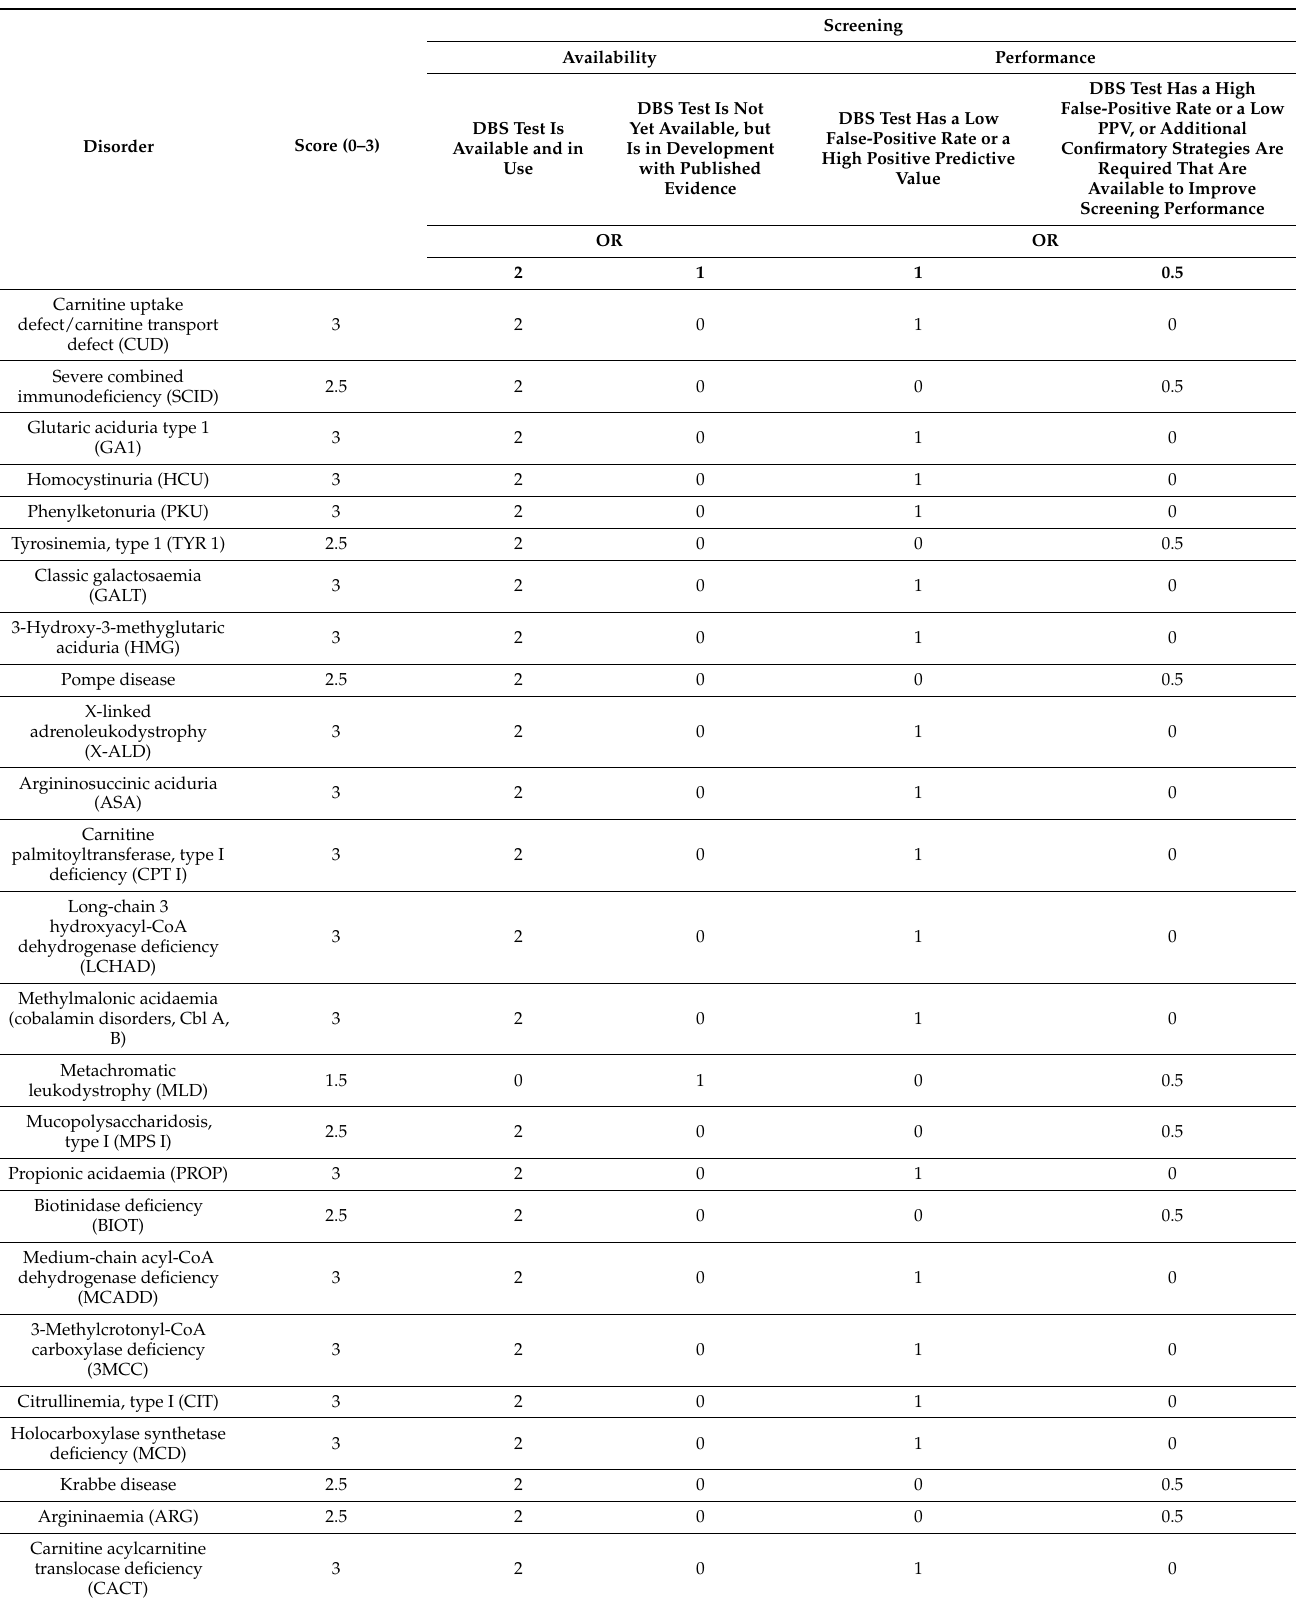
Table A3. Scoring of IMDs using the NBS evaluation algorithm: pillar Screening